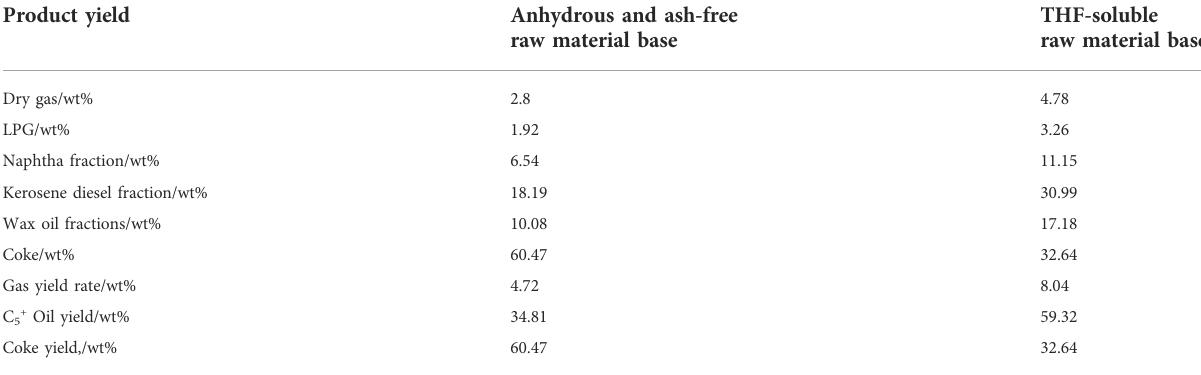
TABLE 2 Distribution of pyrolysis experimental data products of the coal liquefaction residue fl uidized bed. Product